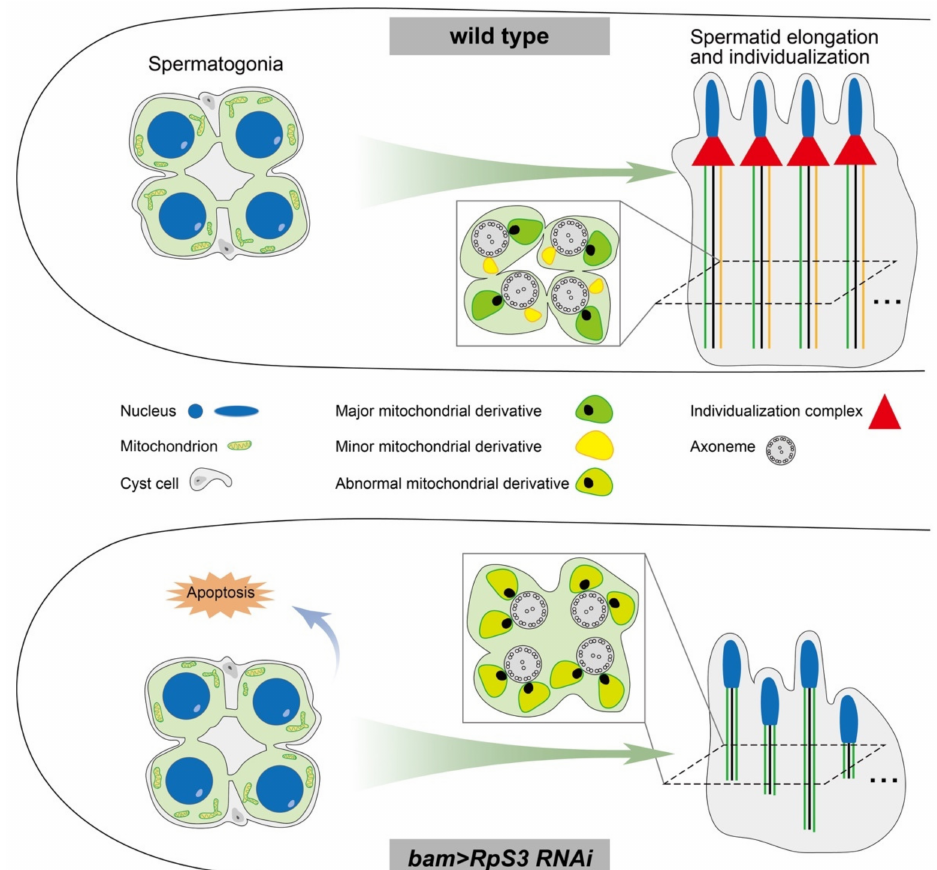
Figure 8. A model showing that RpS3 knockdown in males affects male fertility in D. melanogaster